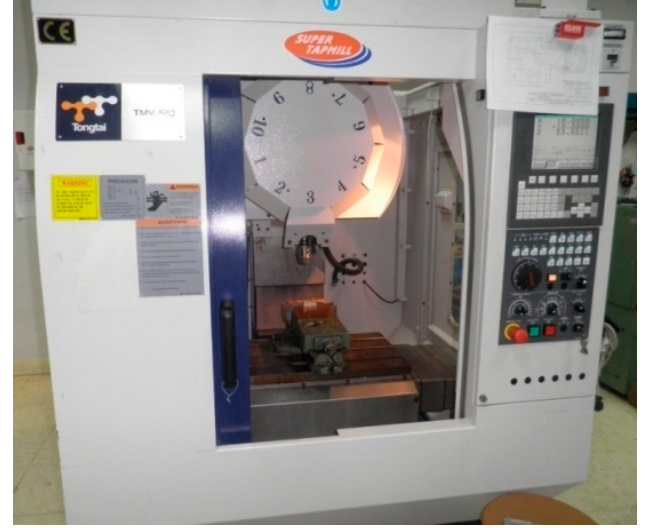
Figure 4. Tongtai TMV510 machining center equipped with a Fanuc Control Numeric Computer (CNC).